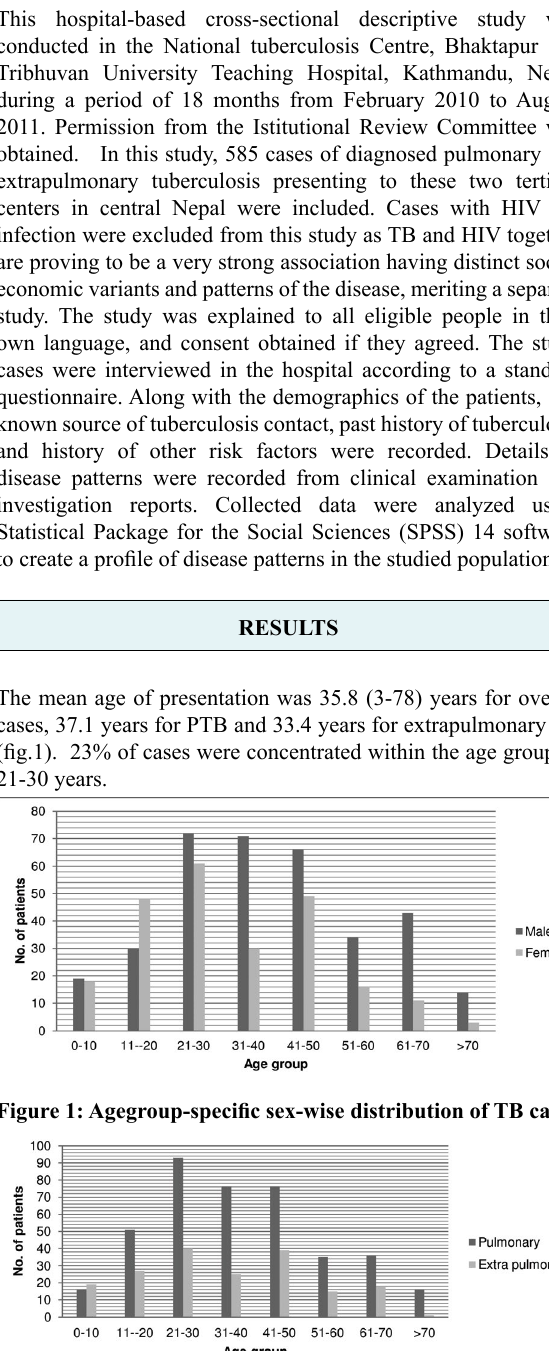
Fig 2: Agegroup-specific distribution of cases according to the site of primary disease